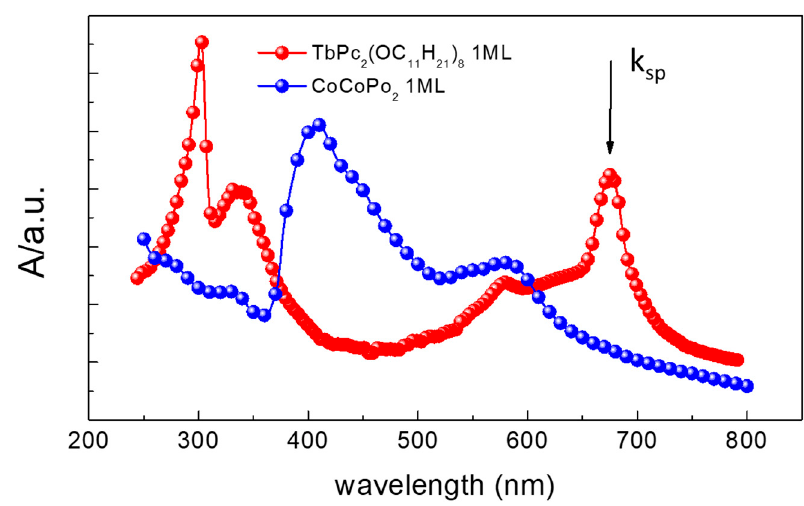
Figure 8. UV-VIS electronic absorption spectra comparison of TbPc 2 (OC 11 H 21 ) 8 and CoCoPo 2 monolayer deposited onto silica glass substrate. The position of the transducers surface plasmon resonance energy coupling with electronic transition of the TbPc 2 (OC 11 H 21 ) 8 is evidenced.